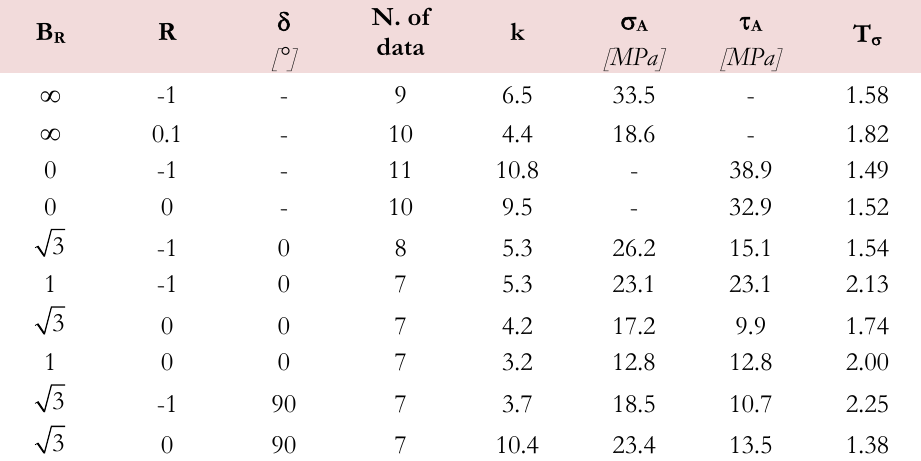
Table 1: Summary of the generated experimental